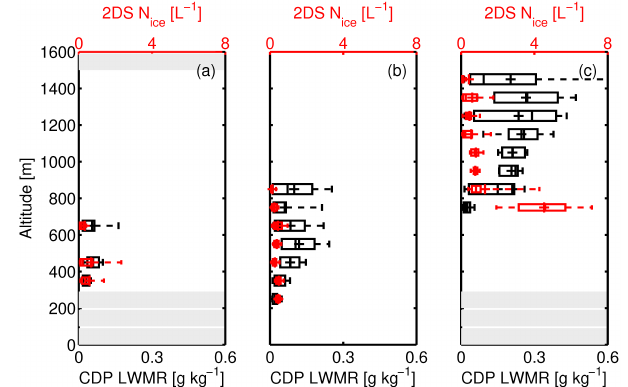
Figure 4. Observations of 2DS ice number concentration (red) and CDP liquid water mixing ratio (LWMR, black). (a) Sea ice, case 1. (b) MIZ, case 2. (c) Ocean, case 3. Only observations from mixed- phase clouds are included, with a derived CDP liquid water content threshold of ≥ 0.01gm − 3 distinguishing in-cloud measurements. Box edges: 25th and 75th percentiles, Median is | , and mean is + . Altitudes not sampled by the aircraft are indicated with grey